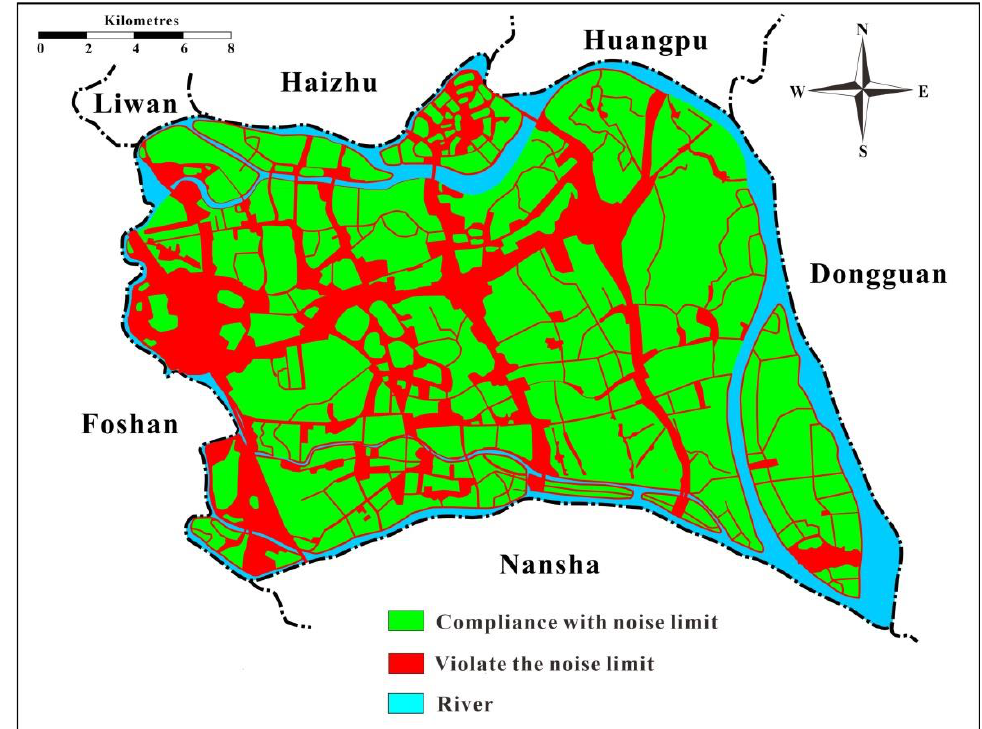
Figure 10. Daytime noise level compliance map in Panyu District of Guangzhou City.